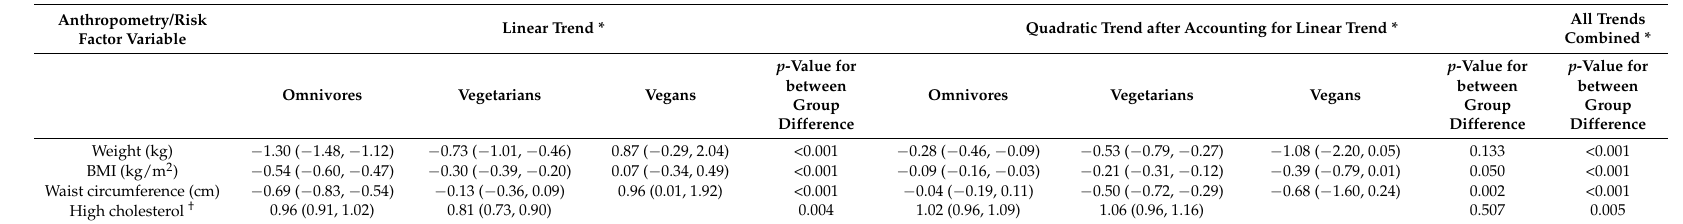
Table 6. Effect modification of anthropometric and risk factor associations by dietary pattern.